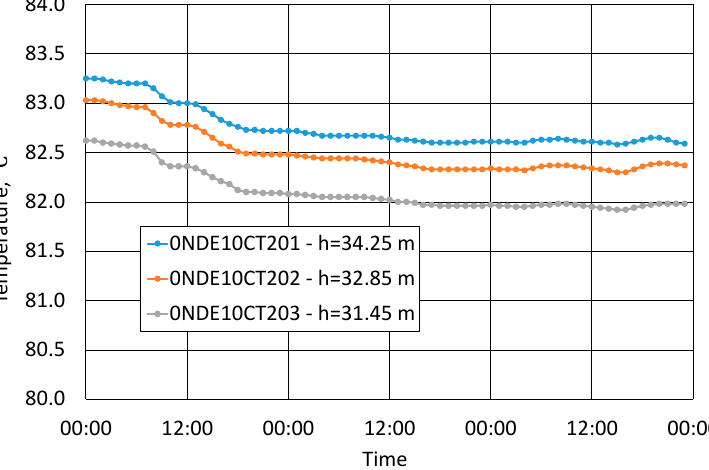
82.583.083.584.0 80.080.581.081.582.0